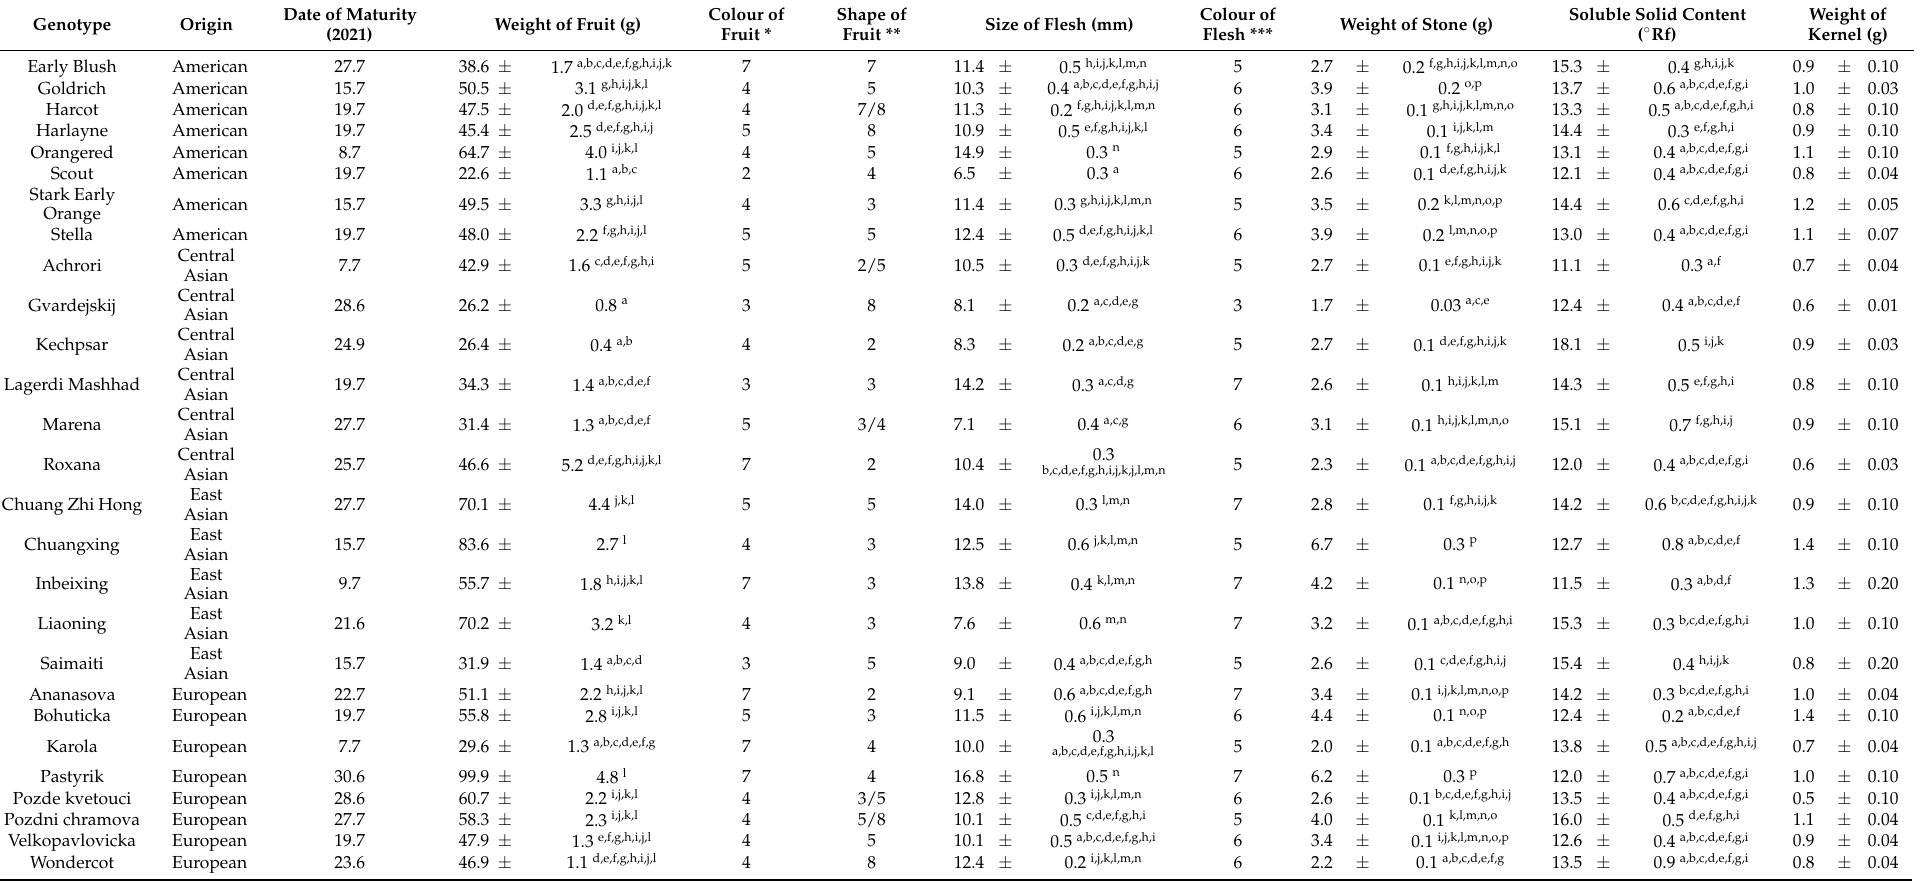
Table 1. The pomological traits of apricot cultivars. Data are displayed as the mean ± standard deviation of ten replications in 2018–2021. In the columns, the mean values followed by different letters are significantly different ( p < 0.05) based on post-hoc analysis of the Kruskal-Wallis test by multiple comparison of mean ranks for all groups (a . . . p). * 1—white, 2—cream beige, 3—yellow, 4—light orange, 5—orange, 7—deep orange; ** 1—deformed, 2—flat, 3—rounded,